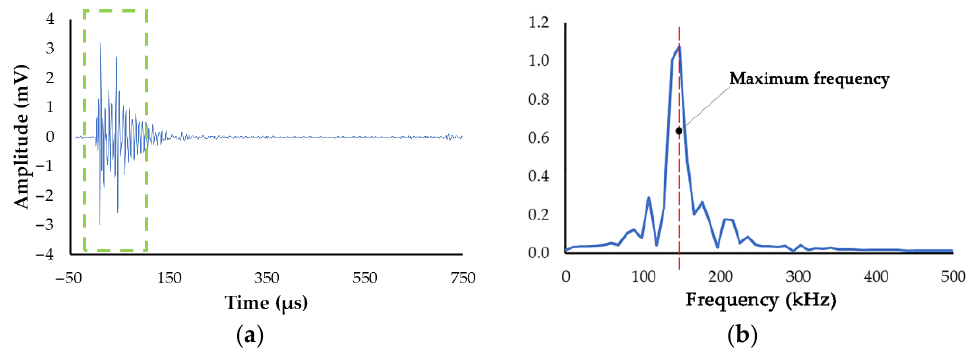
Figure 19. Acoustic emission signal recorded on the beam 1. ( a ) temporal signal; ( b ) frequency spec- trum calculated in the time window indicated as a green box.